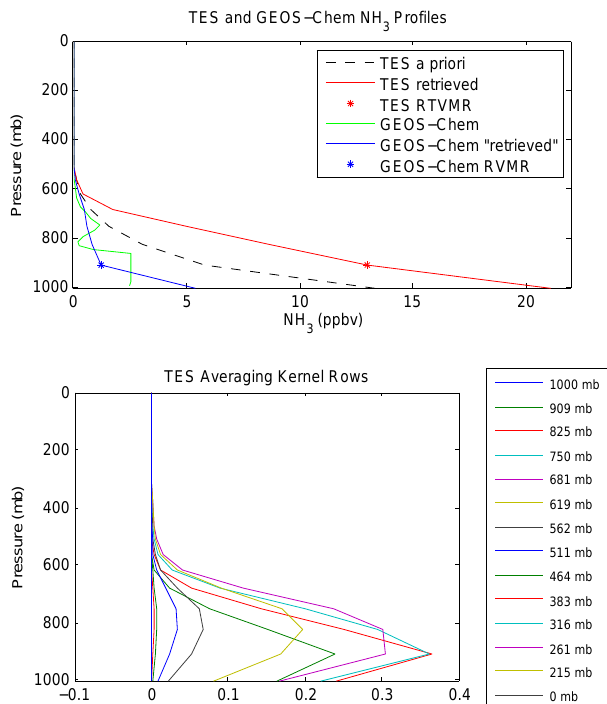
Fig. 13. Example ammonia profiles (TES, GEOS-Chem, and GEOS-Chem with the TES satellite operator applied) and TES av- eraging kernel, for the TES measurement at (120.39 ◦ W, 37.35 ◦ N), 18 May 2009, 01:30p.m.PST and corresponding GEOS-Chem grid box and